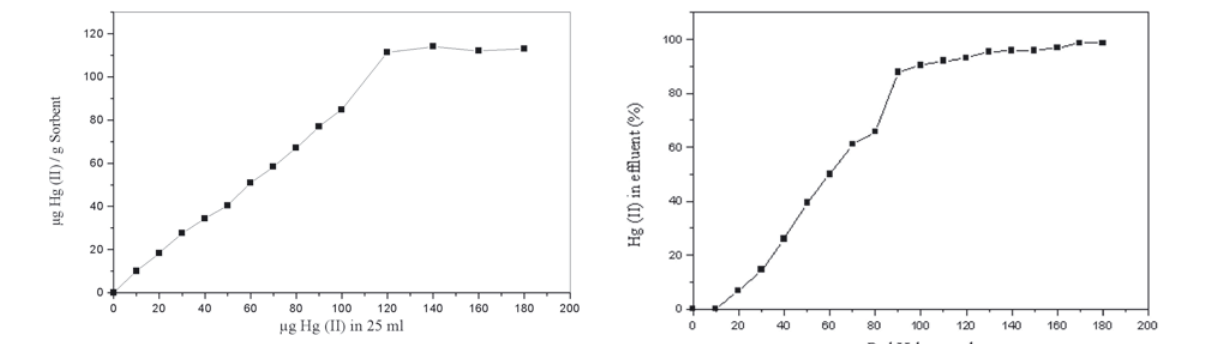
Figure 3. Extraction isotherm of Hg(II) onto MR-PUF average of three determinations. Figure 4. Breakthrough capasity Hg(II) onto MR-PUF average of